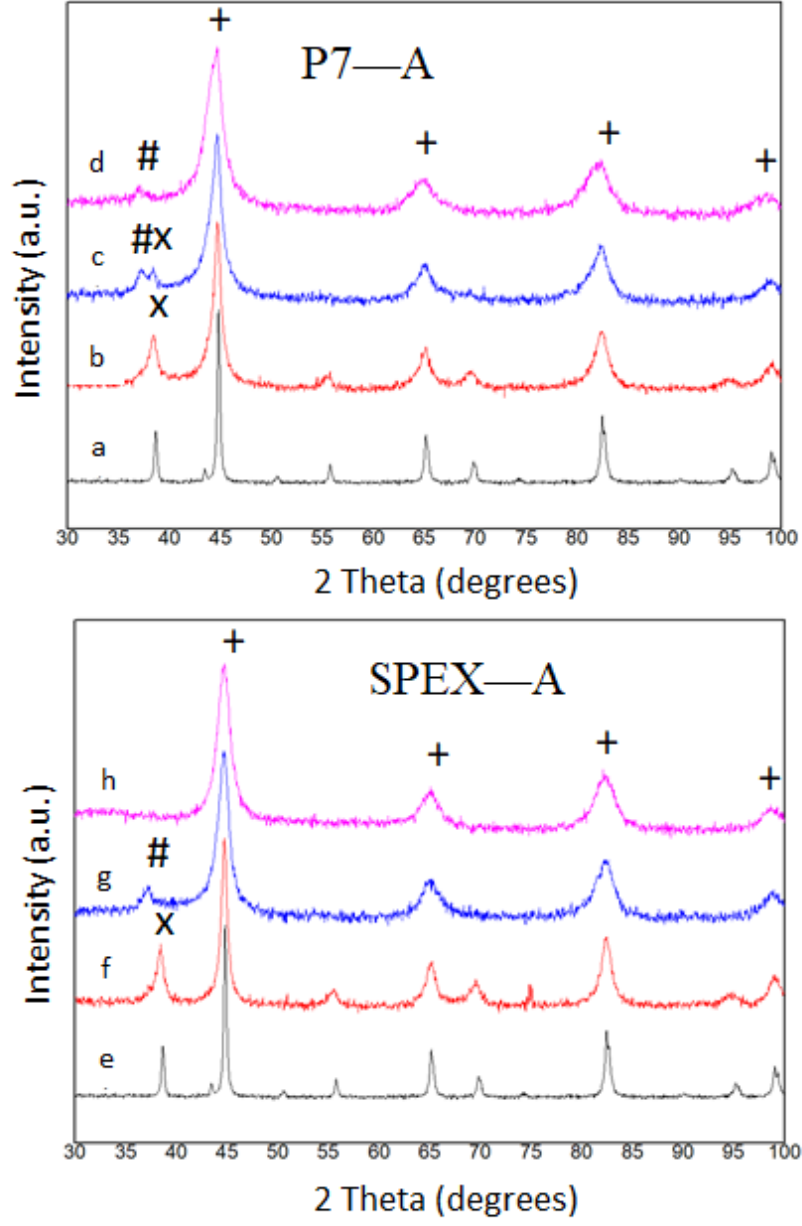
Figure 1. XRD (X-Ray diffraction) patterns of alloy A (Fe 80 Nb 7 B 12 Cu 1 ). In the P7: ( a ) Before milling (0 h) and after milling (( b ) 5 h, ( c ) 20 h, ( d ) 80 h); or in the Spex mill: ( e ) Before milling (0 h) and after milling (( f ) 5 h, ( g ) 20 h, ( h ) 80 h). Bcc Fe rich solid solution (+), Nb phase (X), Nb(B) phase (#).